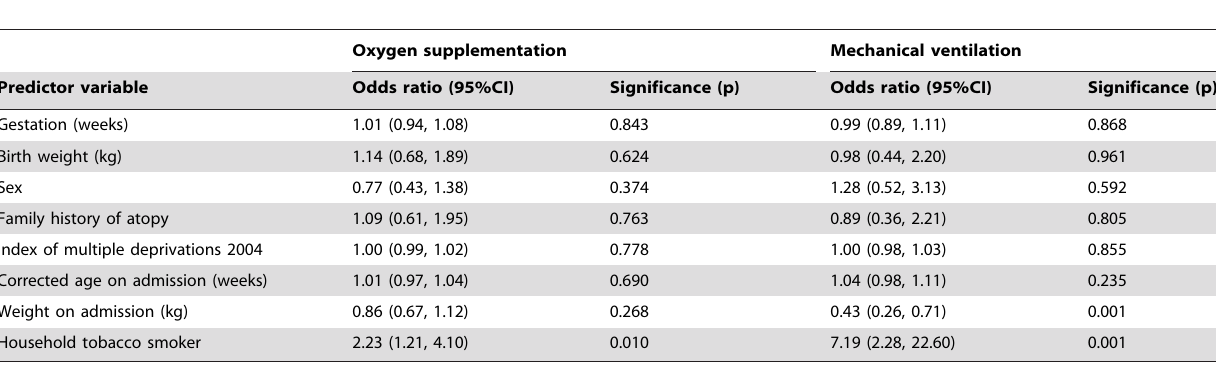
Table 4. Results of multivariate analysis including all potential covariates predicting severe bronchiolitis in 378 infants admitted to hospital.